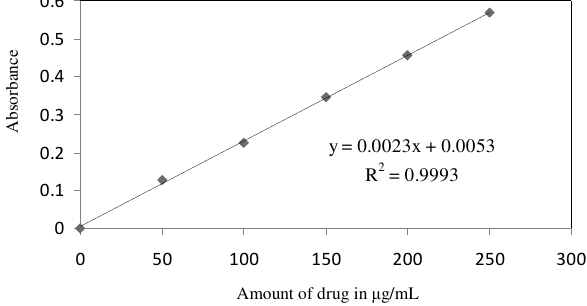
Figure 3. Calibration curve of